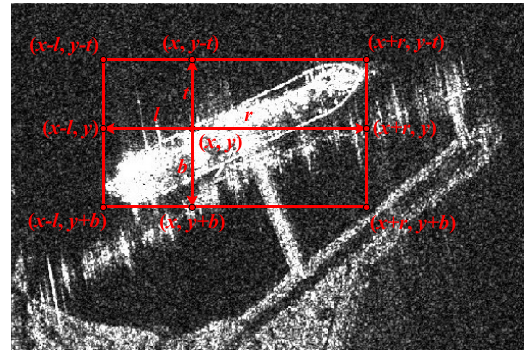
Figure 6. A new feature representation for the bounding box.